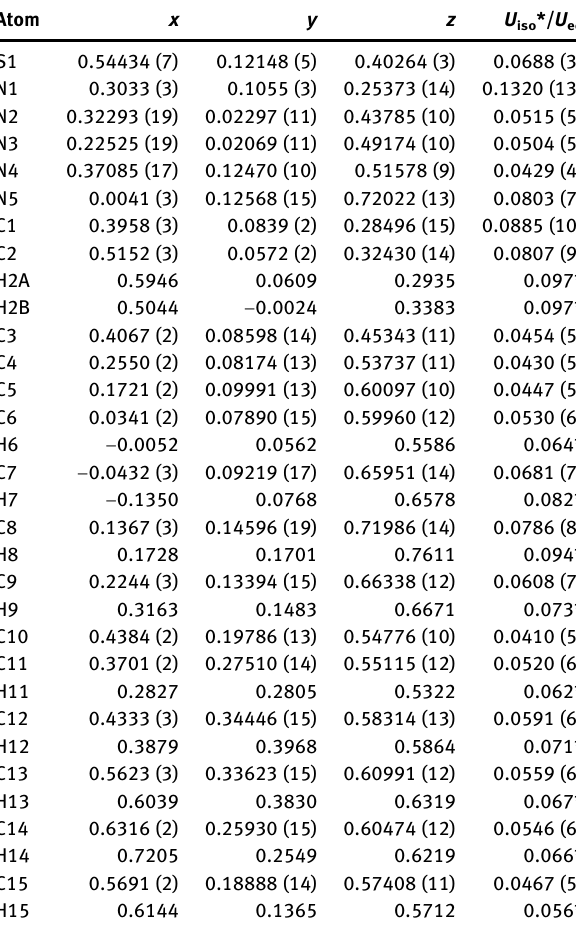
Table  : Fractional atomic coordinates and isotropic or equivalent isotropic displacement parameters (Å 